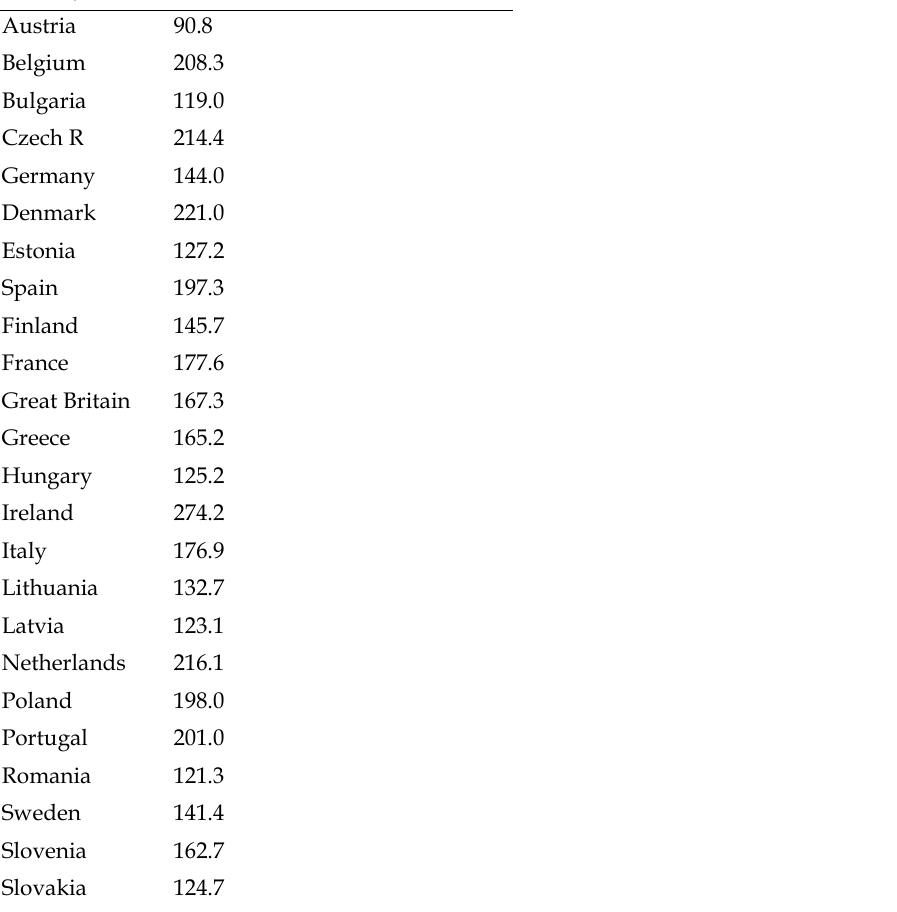
Table 7. Coefficient of variation of the market potential received by each